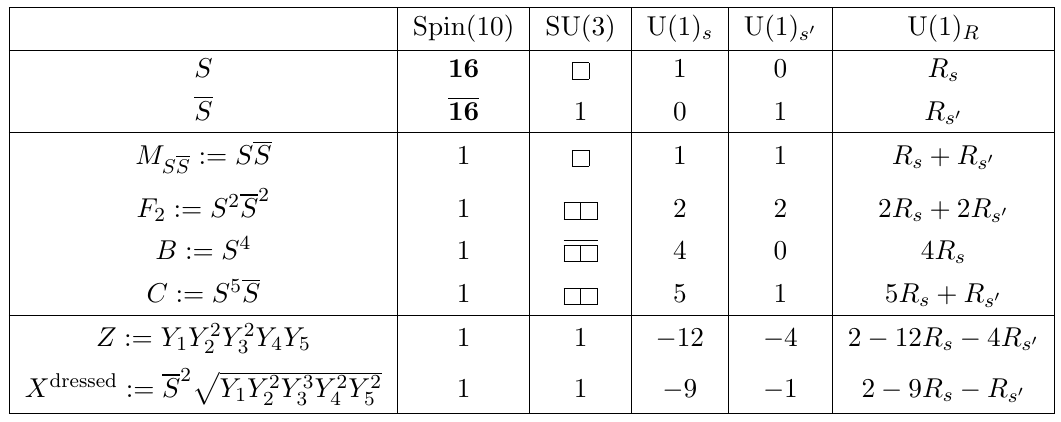
Table 16 . 3d N = 2 Spin(10) theory with ( N v ; N s ; N s 0 ) = (0 ; 3 ;